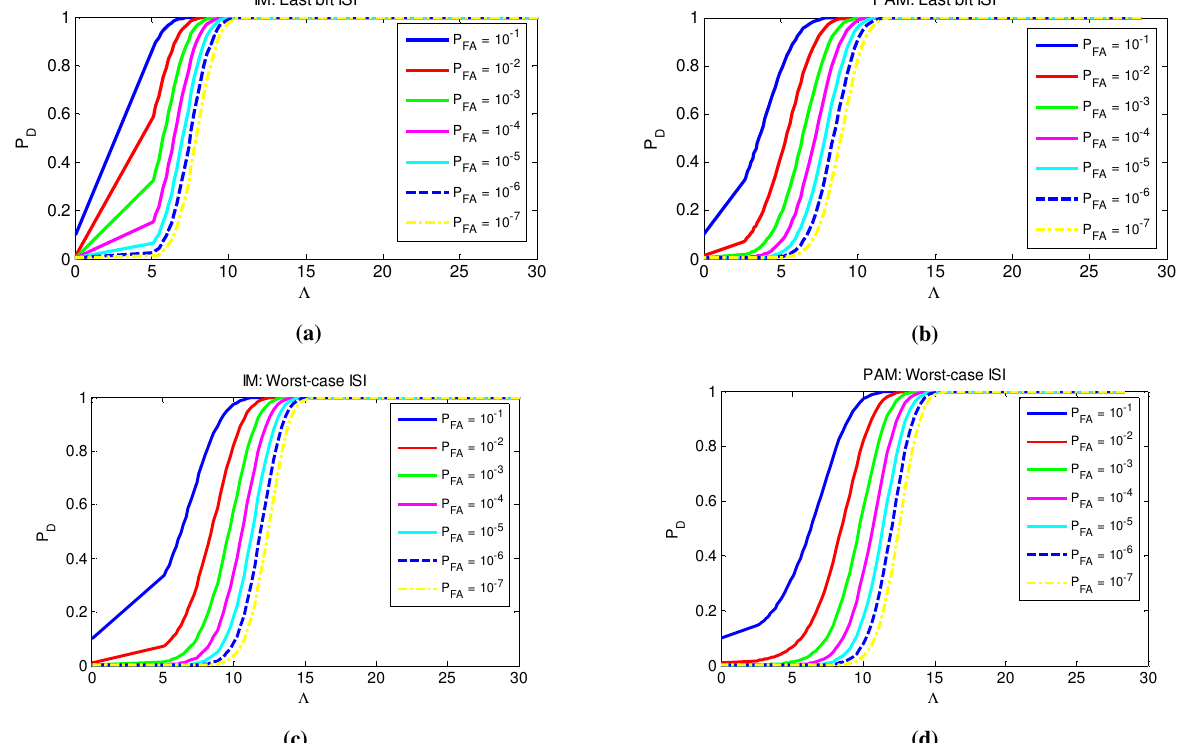
Fig. 4. Detection probability versus SNR characteristics in the presence of